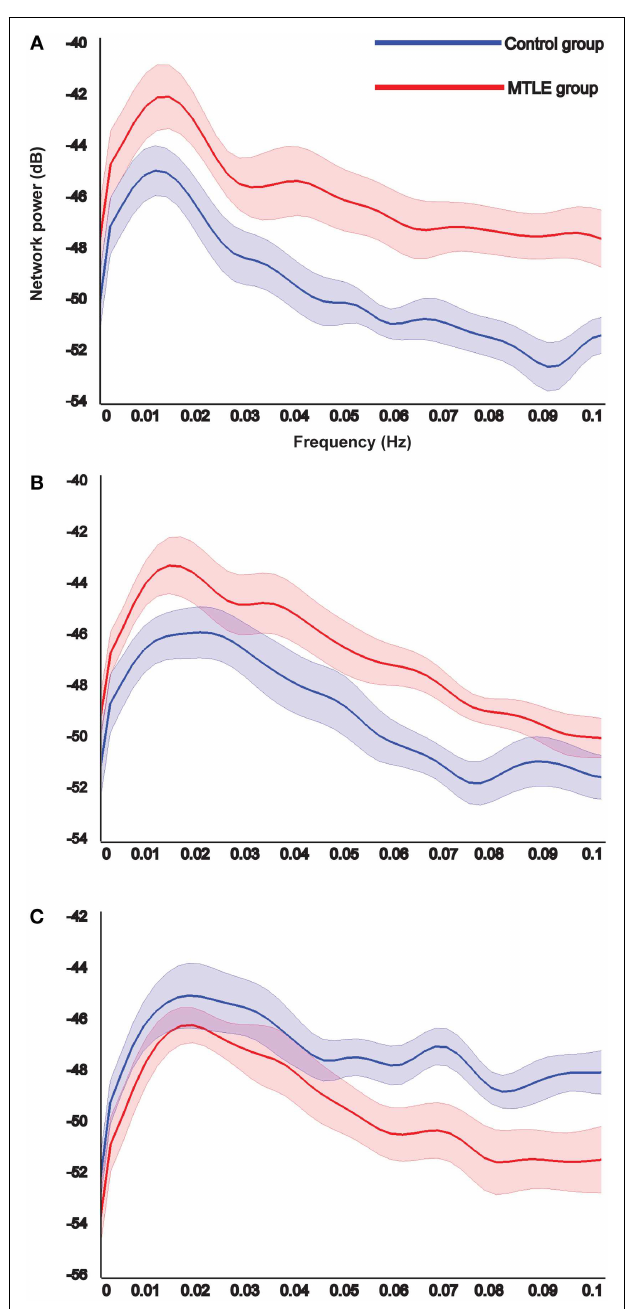
FIGURE 3 | Results of the power spectrum analysis on the temporal dynamics of each detected specific resting-state networks .The reliable resting-state networks specific to the MTLE group show increased functional connectivity in patients compared to controls (A,B) , whereas the reliable resting-state network specific to the controls shows the opposite (C) . X -axis shows the frequency in Hertz and Y -axis indicates the power in decibel. Shaded area shows standard error of the